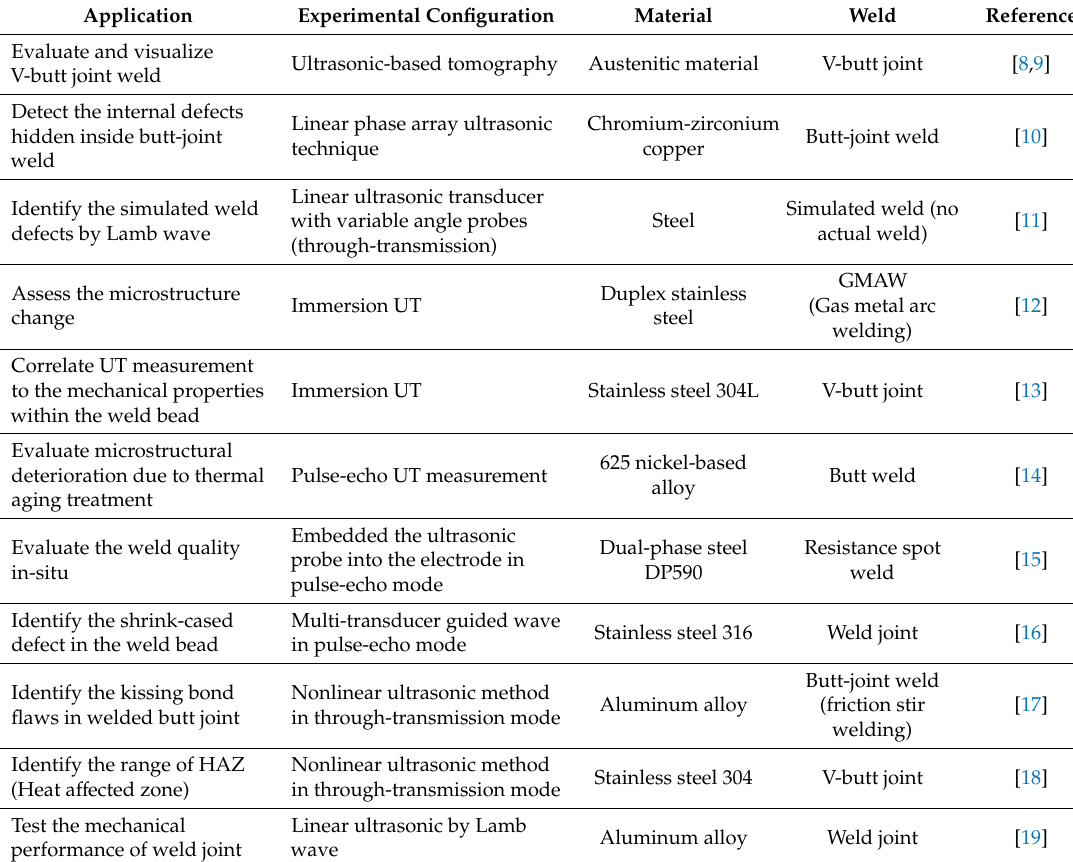
Table 1. Examples of Ultrasonic Testing (UT) studies for weld